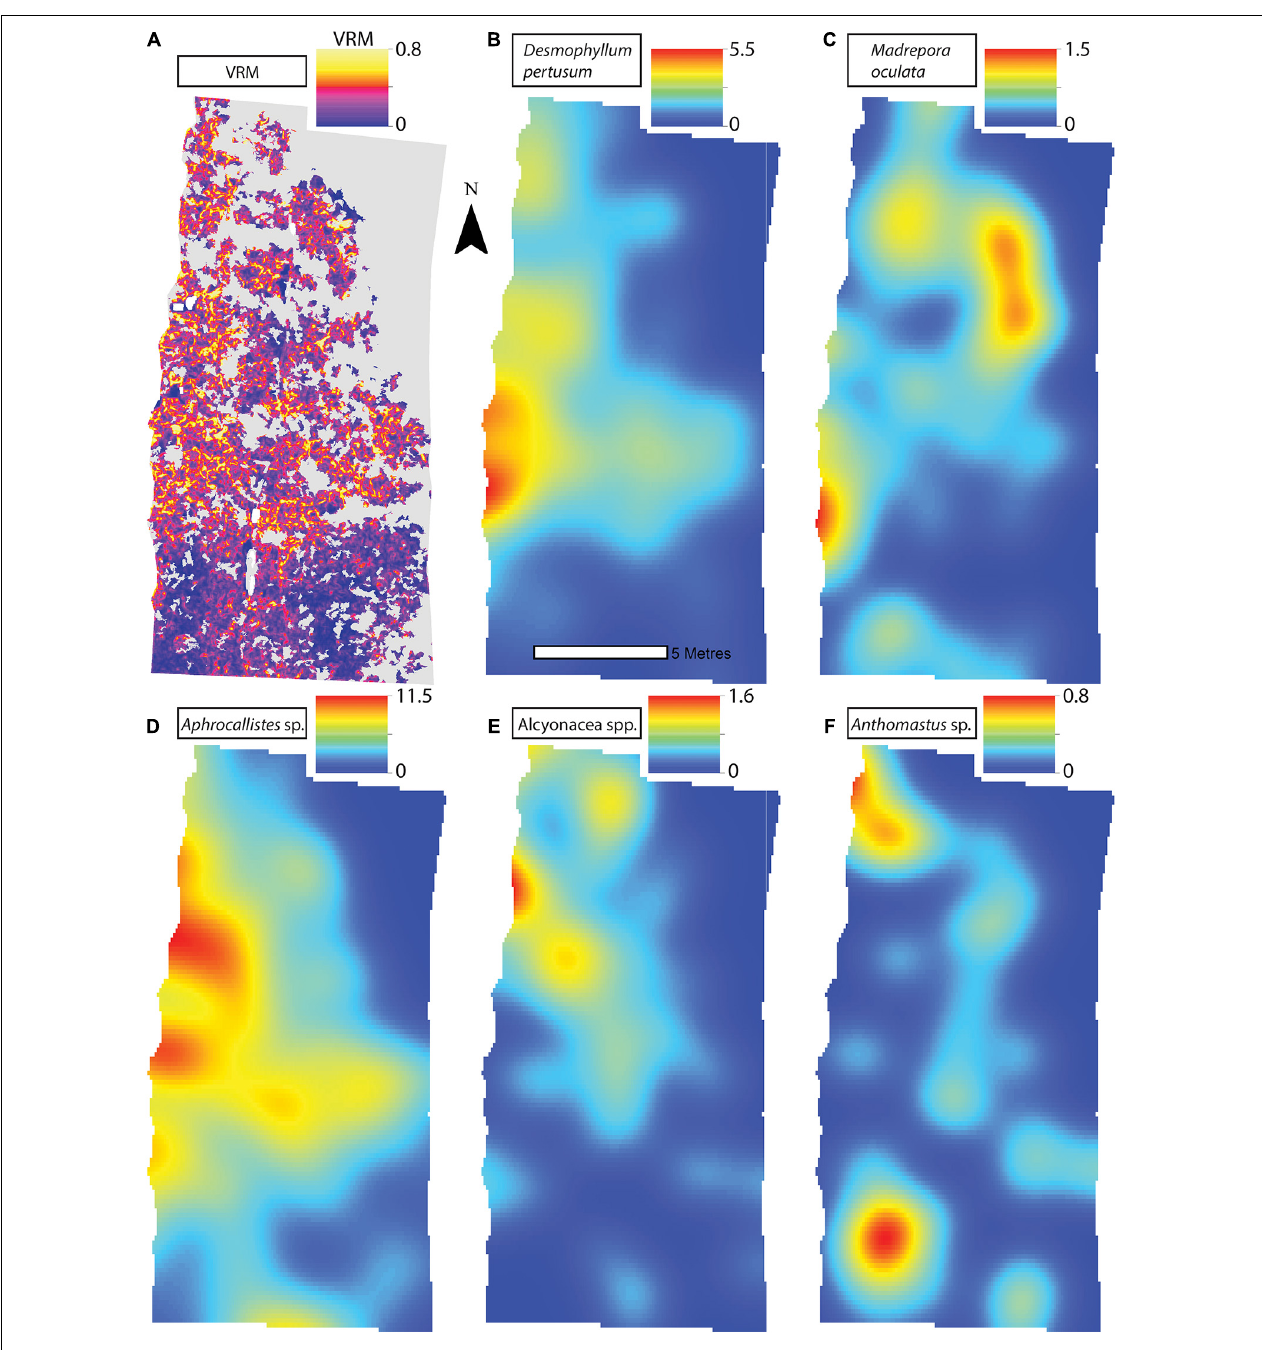
FIGURE 7 | (A) Vector Ruggedness Measure values for reef facies at Site A. Kernel estimate of intensity plots (number of individuals per m 2 and sigma = 1) (B) Desmophyllum pertusum , (C) Madrepora oculata , (D) Aphrocallistes sp., (E) Alcyonacea spp., and (F) Anthomastus sp. for Site A. Note varying colour scale between the different